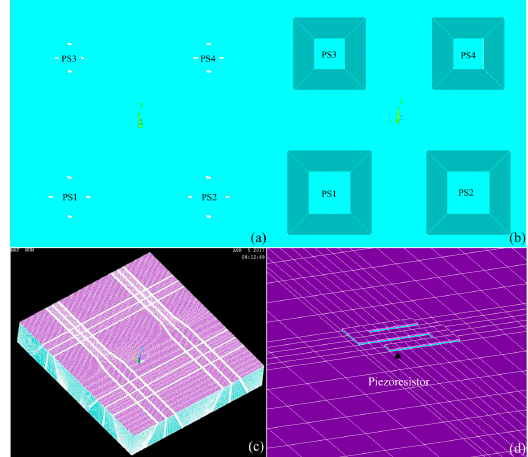
Figure 3. ( a ) Top view of finite element (FE) model of the array-type pressure sensor; ( b ) bottom view of FE model of the array-type pressure sensor; ( c ) three-dimensional FE mesh of the array-type pressure sensor; and ( d ) three-dimensional FE mesh of the piezoresistor area.